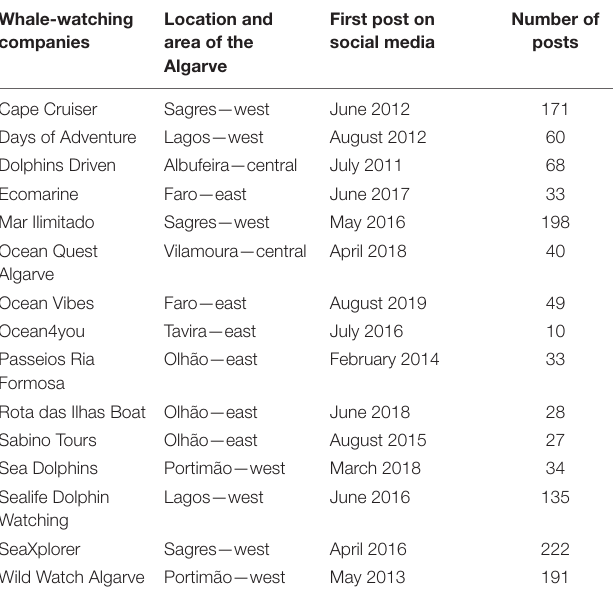
TABLE 1 | List of whale-watching companies located in the Algarve (Portugal) with active social media accounts on Facebook and Instagram in December 2020, and the number of time-referenced posts published by each company since their first post on social